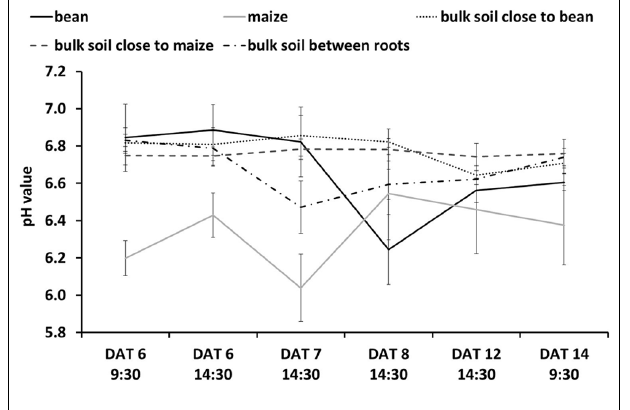
FIGURE 5 | pH Dynamics over time as related to different ROIs either in the rhizosphere of maize or bean (i. e., positioned centrally on the individual root), in the bulk soil close to maize or bean roots (i.e., positioned 6–10 mm away from the individual root), or in the bulk soil between maize and bean roots (i.e., positioned centrally between roots with >6 mm distance between them) .Values are means and standard errors of the mean of all pixels (approx. 2500–3500 pixels for the rhizosphere and 10000–15000 pixels for bulk soil) in the individual ROI. Note that these mean values are derived solely from intercropping rhizotrons, such that they are composed of values from rhizotrons with maize intercropped with one or with two bean individuals. For maize n = 4 DAT 6–8 and 14, n = 3 DAT 12; bean n = 4 DAT 6–8, n = 3 DAT 12–14; bulk soil close to bean/maize n = 4 DAT 6–14; bulk soil between roots n = 4 DAT 6–8, n = 2 DAT